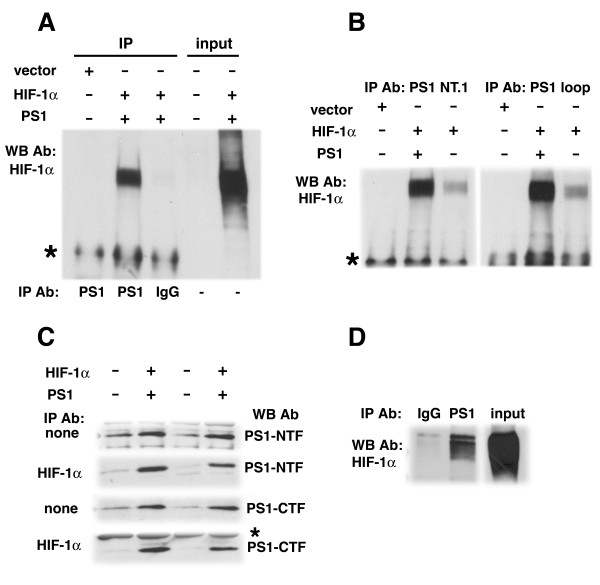
Physical interaction between HIF-1α and Psen1. Expression vectors carrying no insert, Psen1 or HIF-1α were transfected into HEK 293 cells in the indicated combinations. In panel A, immunoprecipitations (IP) were performed with a polyclonal anti-Psen1 antibody which recognizes the Psen1 NTF or with rabbit IgG as control and Western blotting was performed for HIF-1α. Total extracts without IP (-) (5% of input) were loaded in the two far right lanes (input). Note the co-immunoprecipitation of HIF-1α in the cultures co-transfected with HIF-1α and Psen1. A similar experiment was performed in (B), except that immunoprecipitations were performed with the monoclonal antibody NT.1 which recognizes the Psen1 NTF or with an antibody against the Psen1 loop region. In panel C, immunoprecipitation was done with a monoclonal HIF-1α antibody followed by Western blotting with an antibody against the Psen1 NTF (NT.1) or CTF (33B10). Panels labeled "none" show blots of total extracts prior to immunoprecipitation (input). Bands marked with an asterisk (*) are likely IgGs based on the rate of migration. Panel D shows the co-immunoprecipitation of endogenous HIF-1α by endogenous Psen1. Wild type fibroblasts were treated for 4 hours with 100 μM CoCl2 and 10 μM MG132 to induce HIF-1α accumulation and co-immunoprecipitations were performed as in (A).